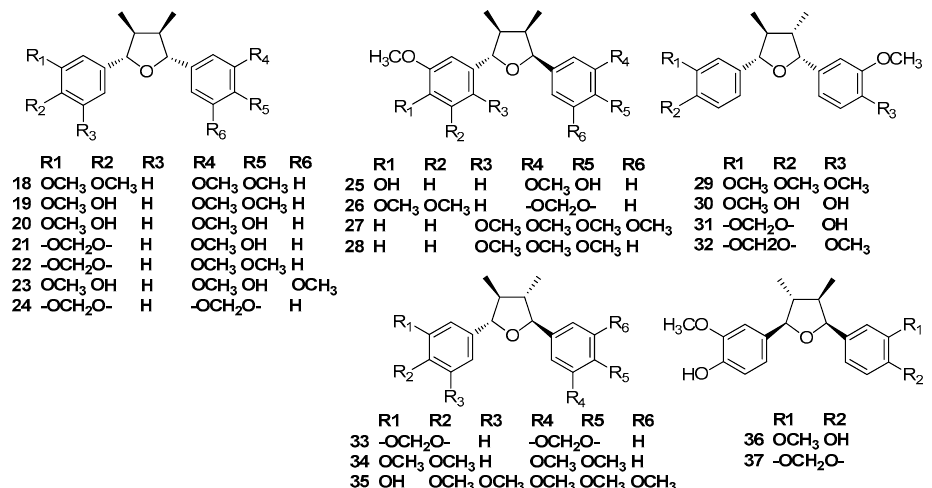
Figure 3. Chemical structures of 7,7’-epoxylignans.